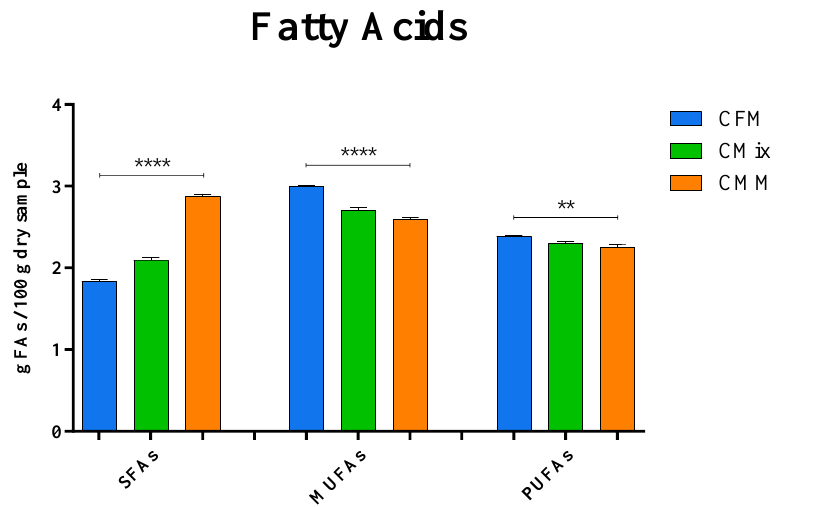
Figure 4. FA content of CFM, CMix, and CMM formulations for companion animal food. Data are